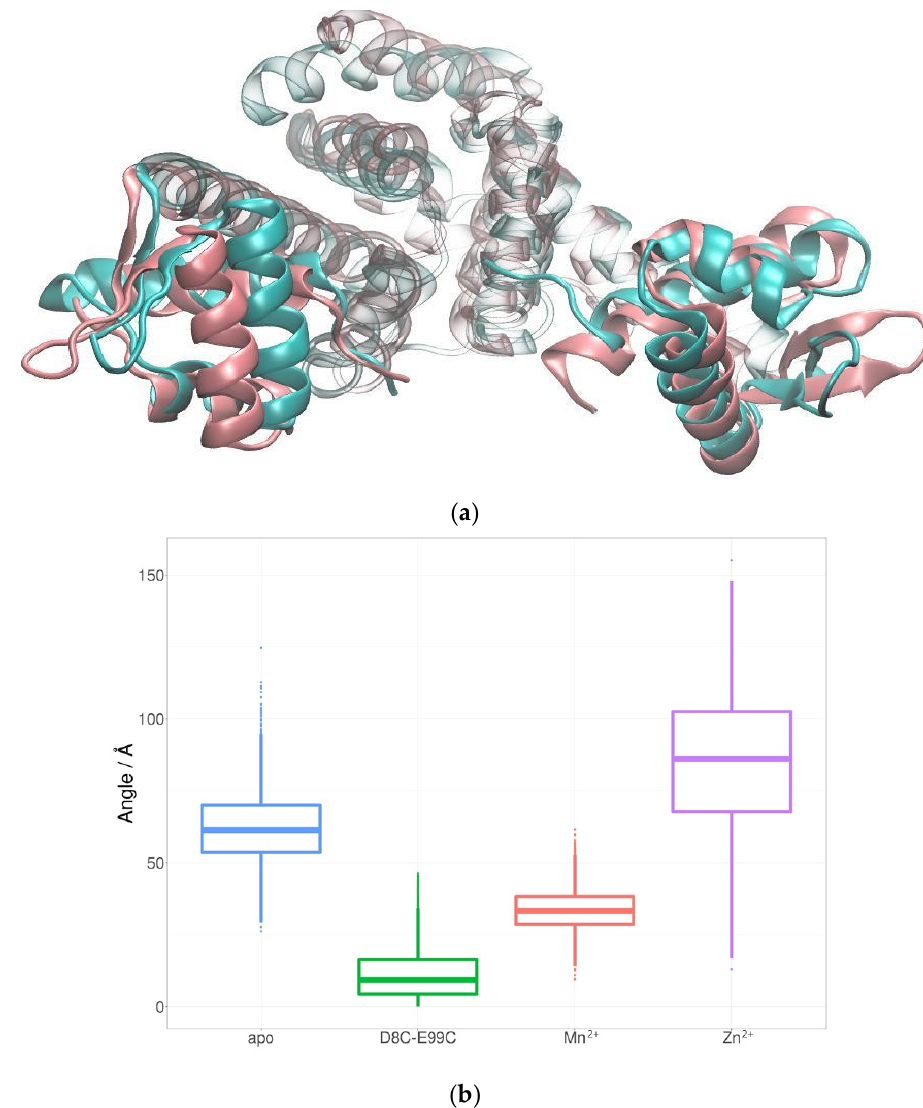
Figure 6. Positions of the DNA-binding helices: ( a ) at the end of the Mn 2+ -bound (pink) and mutant (blue) simulations and ( b ) a boxplot of the dihedral angle between them during the apo (blue), Mn 2+ (pink), mutant (green) and Zn 2+ (purple) simulations.